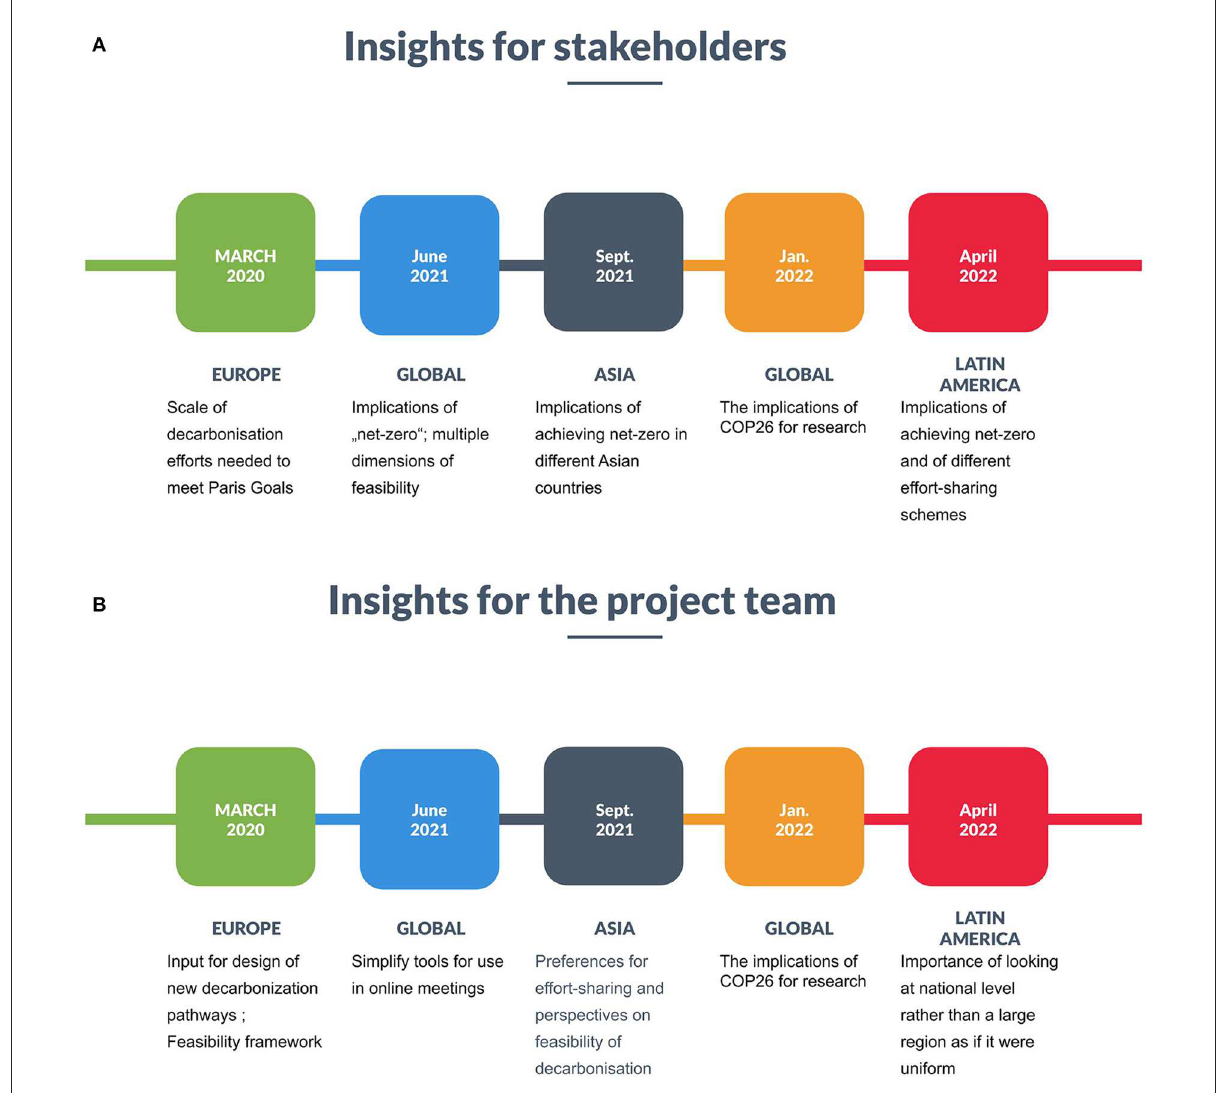
FIGURE6 (A) Insights for stakeholders and (B) the project team in the five